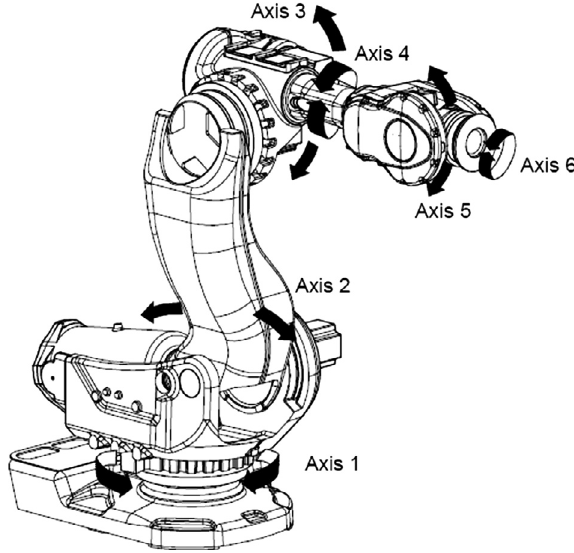
Figure 4. Standard 6 axis Robot model shown IRB 7600 (ABB).